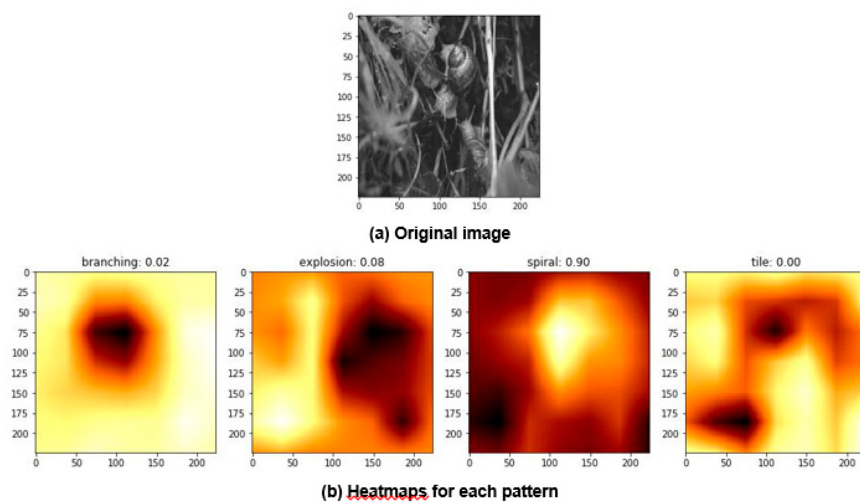
Designs 2019 , 3 , x FOR PEER REVIEW Figure 32. Image classification with pattern distribution. Figure 32. Image classification with pattern distribution.